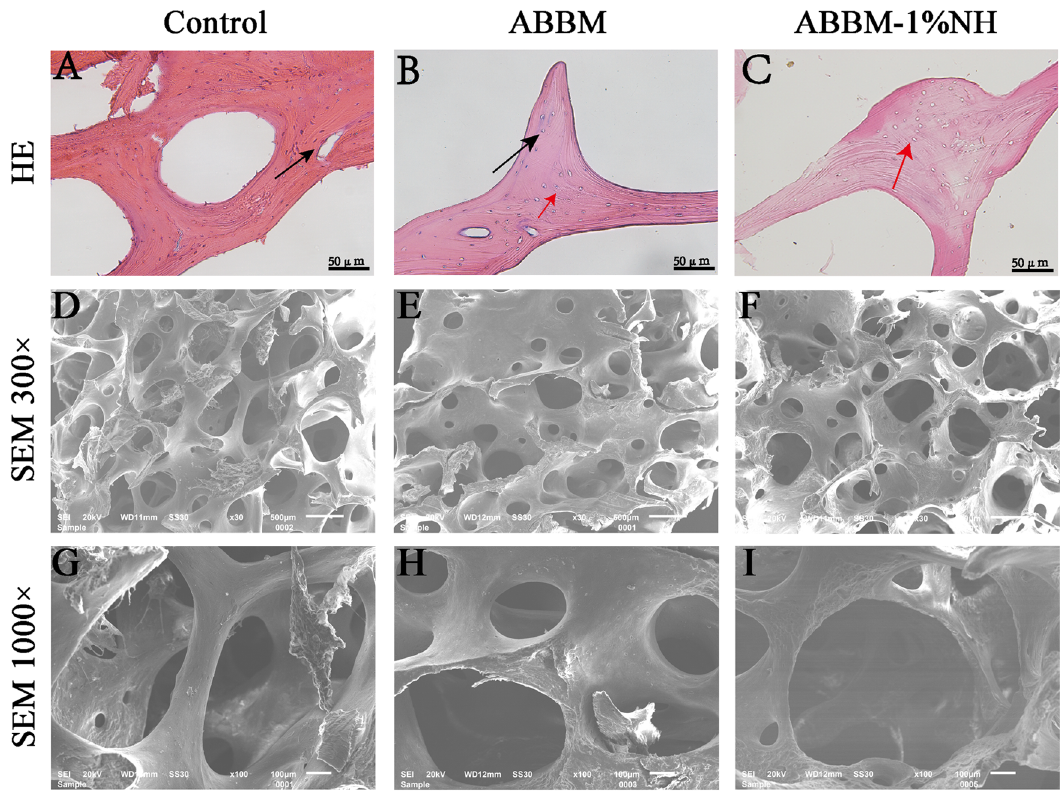
Scanning electron microscope (SEM) ( n = 5), ( D , G ) NBBM; ( E , H ) ABBM; ( F , I ) ABBM-1%NH